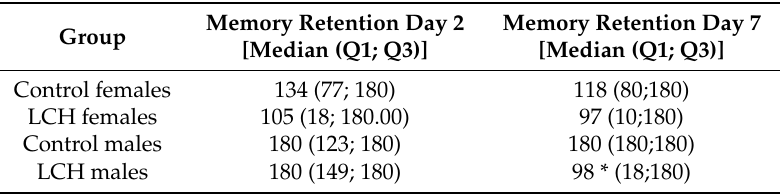
Table 6. Results of passive avoidance task on day 2 and 7.